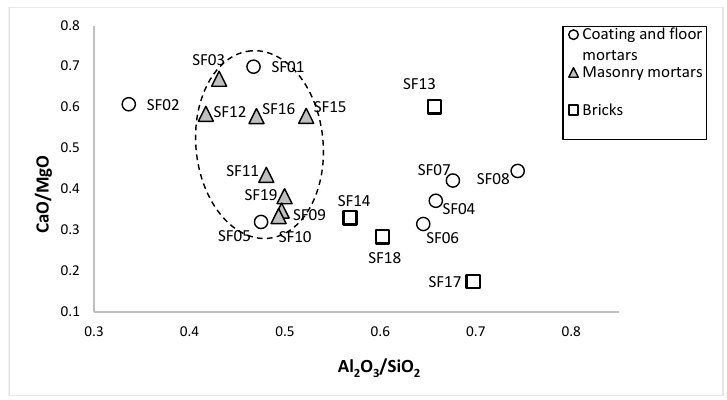
Figure 7. Mortars and bricks CaO/MgO vs. Al 2 O 3 /SiO 2 binary diagram. The cluster analysis of the trace elements composition showed two main samples associations (Figure 8a): group i, including MM samples and CFM SF01, SF04, SF05 and SF07 samples, and group ii, with bricks and the remaining CFM SF02, SF06 and SF08 samples. The variable cluster analysis revealed that Ba, Cl and Zr concentration trends were distinctive from the others, forming a distinctive cluster (Figure 8b). Excluding some samples, in general, group i showed higher Ba (500–900 mg/kg), Sr (86–180 mg/kg, except in SF04 and SF07 samples, with 69.2 and 77.6 mg/kg, respectively) and Cl (160–610 mg/kg, excluding SF03 and SF09 both with 120 mg/kg). In group ii, higher Zr (370–590 mg/kg, excluding SF02 with 180 mg/kg) content was found. The CFM samples SF01, SF04 and SF07 in group i (excluding SF05), formed a distinct subcluster, mainly due to its higher Cl and lower Ba and Sr contents. In group ii, the CFM samples SF02, SF06 and SF08 also formed a distinctive cluster (except for SF18, included in CFM subcluster) mainly due to their higher Ba (400–490 mg/kg) and Cl (160–280 mg/kg) and lower Zr (370–480 mg/kg, excluding SF02 with 180 mg/kg) content. Bricks showed the lowest Sr content (35.6–46.1 mg/kg excluding SF17 with 89.8 mg/kg) among all samples.